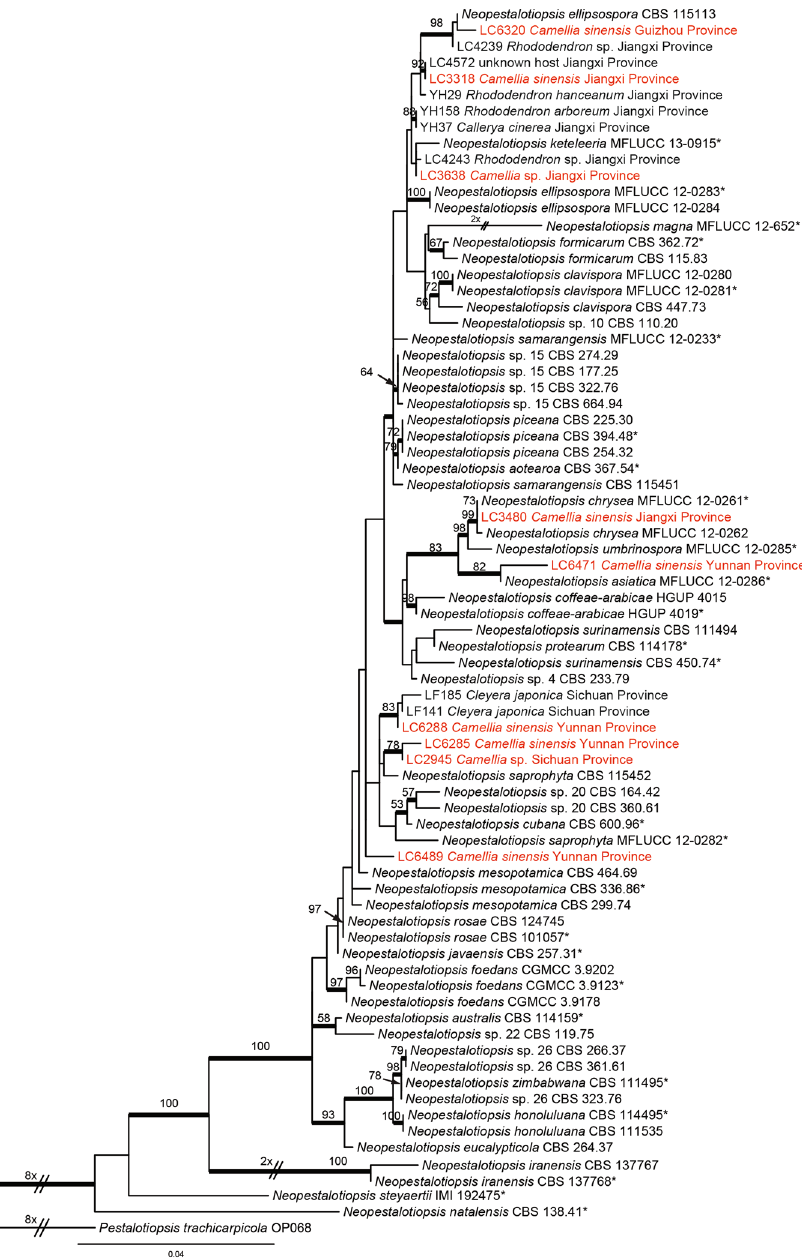
Figure 1. Phylogenetic tree of Neopestalotiopsis calculated with maximum likelihood analysis on a combined dataset of three-locus sequences (ITS, TUB2, TEF) by running RAxML v.7.0.3. The RAxML bootstrap support values ( > 50%) are displayed at the nodes. Thickened branches indicate branches also present in the Bayesian tree with > 0.95 posterior probabilities. Stars indicate ex-type cultures. Strains from Camellia spp. in this study are in red